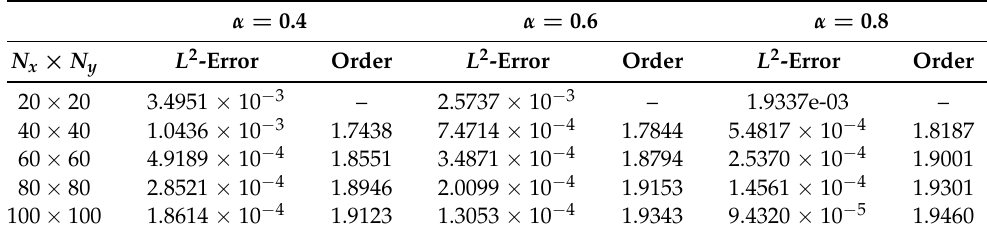
Table 7. The L 2 -norm errors and spatial convergence orders for Example 2 using scheme (48), M = 500, T = 1/4, r = ( 3 − α ) / α , k = 1.